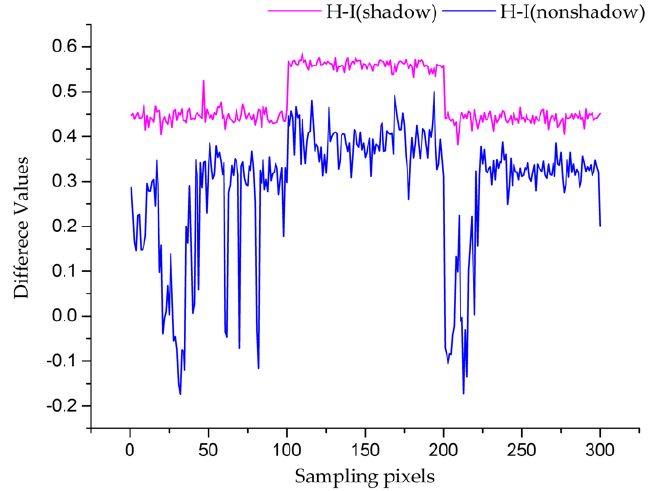
Figure 1. Sampling curves regarding the difference values between the hue component and the intensity component in both shadow and nonshadow regions.